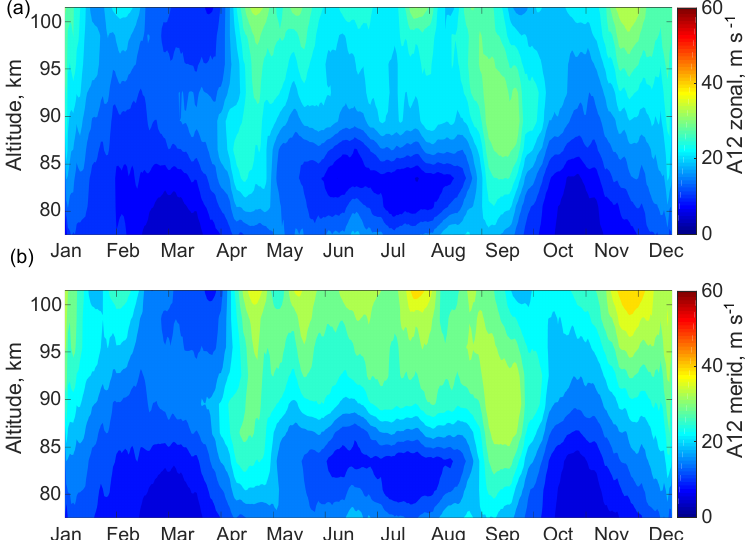
Figure 4. Amplitudes of semidiurnal tides at middle latitudes (corresponding to Juliusruh) extracted from the KMCM simulation. Panels (a, b) correspond, respectively, to the zonal and meridional